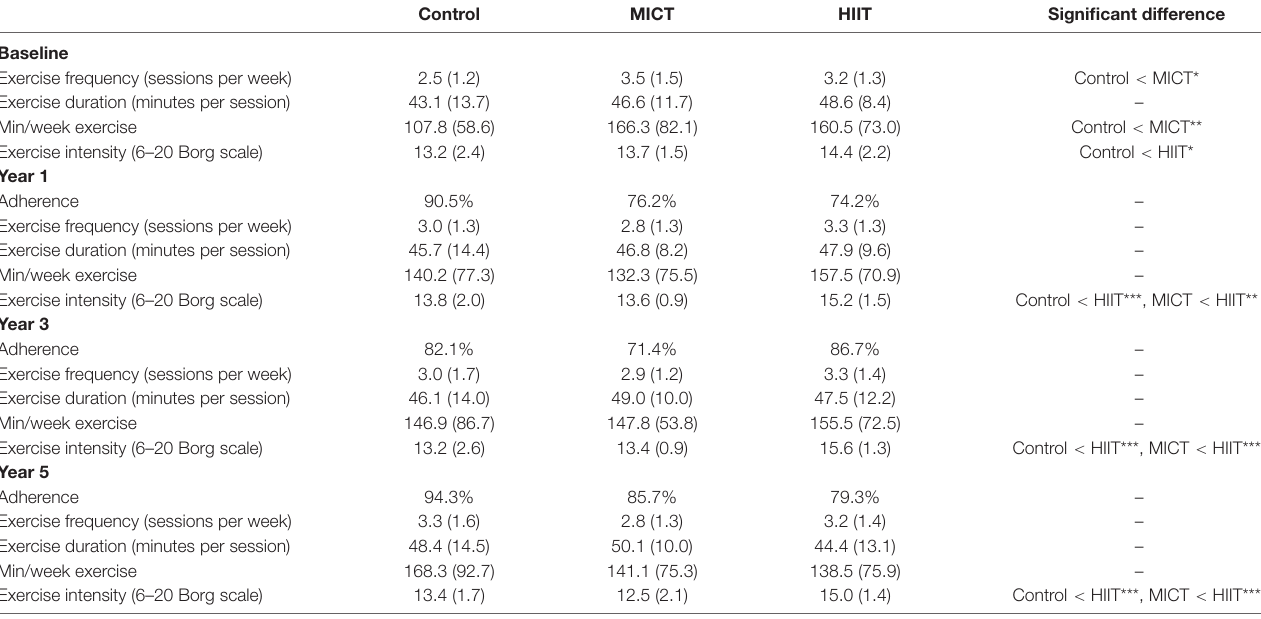
TABLE 2 | Adherence, exercise frequency, duration, and intensity in the control, MICT, and HIIT groups at each time point. Control MICT HIIT Significant difference